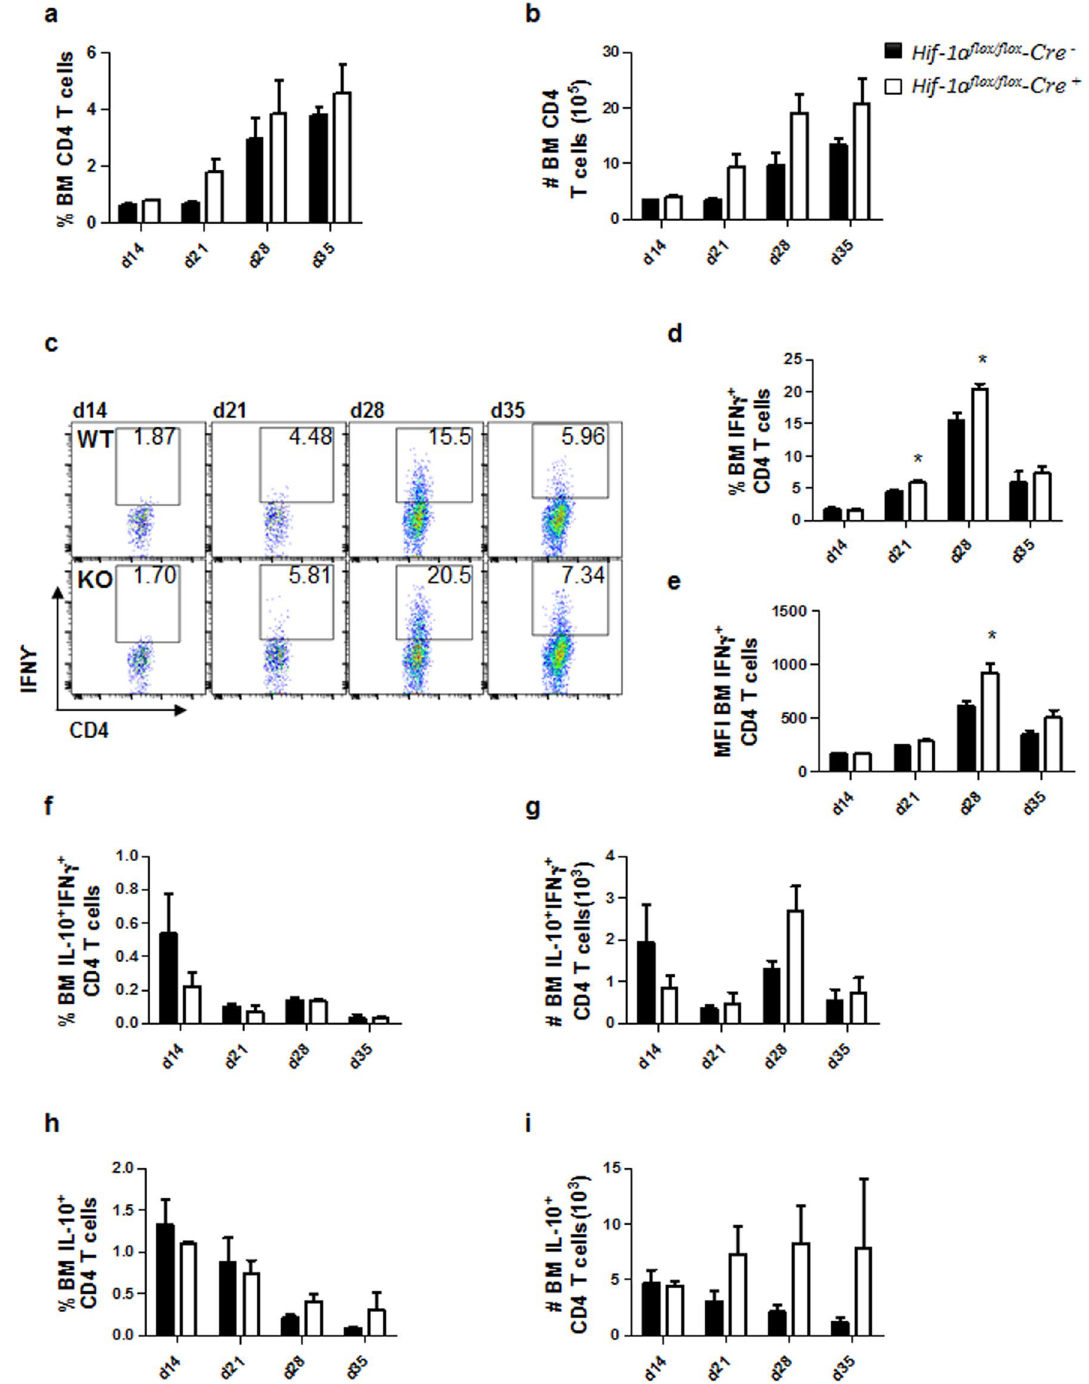
Figure 3. HIF-1 α deficiency in CD11c + cells results in stronger Th1 responses in the bone marrow. Hif-1 α flox/ flox Cd11c-Cre − (WT) and Hif-1 α flox/flox Cd11c-Cre + (KO) mice were infected with 2 × 10 7 LV9 amastigotes intravenously. ( a ) Graph represents the frequency and ( b ) absolute numbers of bone marrow CD4 T cells. ( c ) Representative FACS plots for IFN γ + CD4 T cells of Hif-1 α flox/flox Cd11c-Cre − (upper panels) and Hif-1 α flox/ flox Cd11c-Cre + mice (lower panels) in the bone marrow. ( d ) Percentage and ( e ) mean fluorescence intensity (MFI) of IFN γ + CD4 T cells in the bone marrow. Frequency ( f ) and numbers ( g ) of IFN γ + IL-10 + double producing CD4 T cells; percentage ( h ) and numbers ( i ) of IL-10 + single producers CD4 T cells in the bone marrow over the course of infection. All data represent mean ± SEM of one of 3 independent experiments, n =